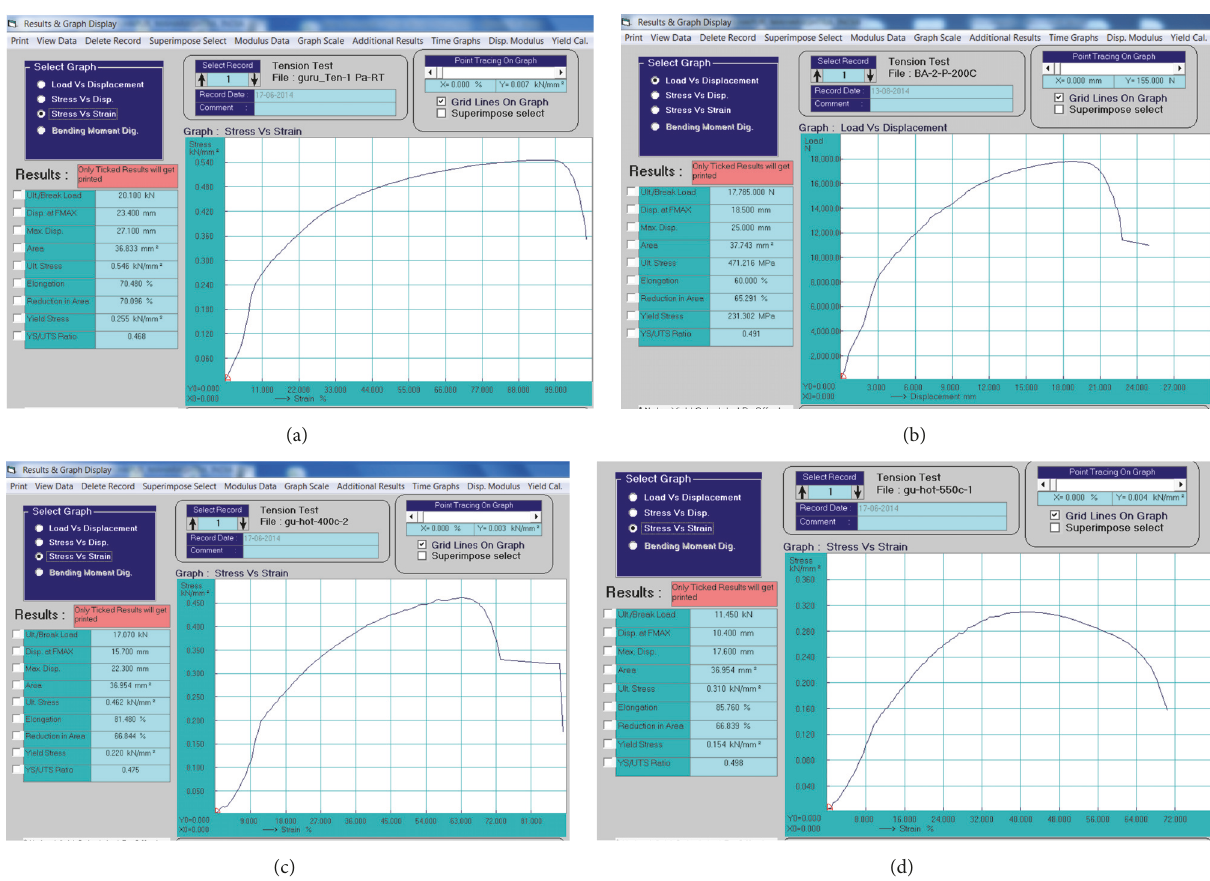
Figure 4: Stress-strain graphs of the parent metal at (a) room temperature, (b) 200 ∘ C, (c) 400 ∘ C, and (d) 550 ∘